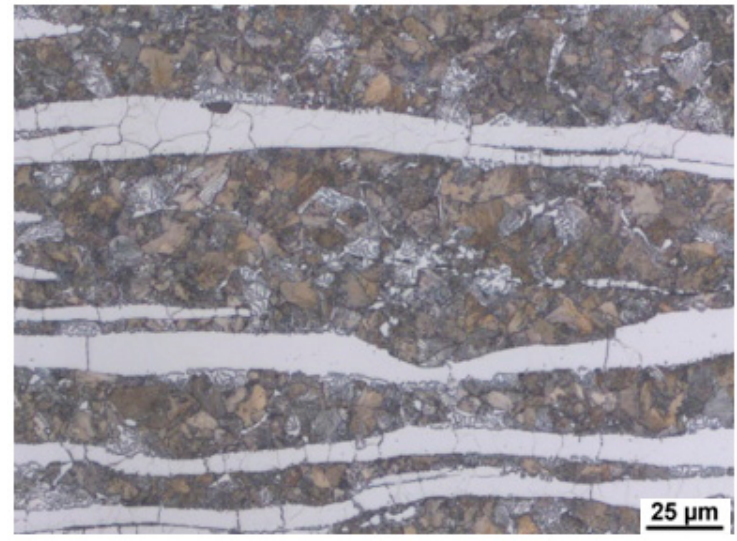
Figure 9. Microstructure of the sheet. Heat A. Longitudinal direction.